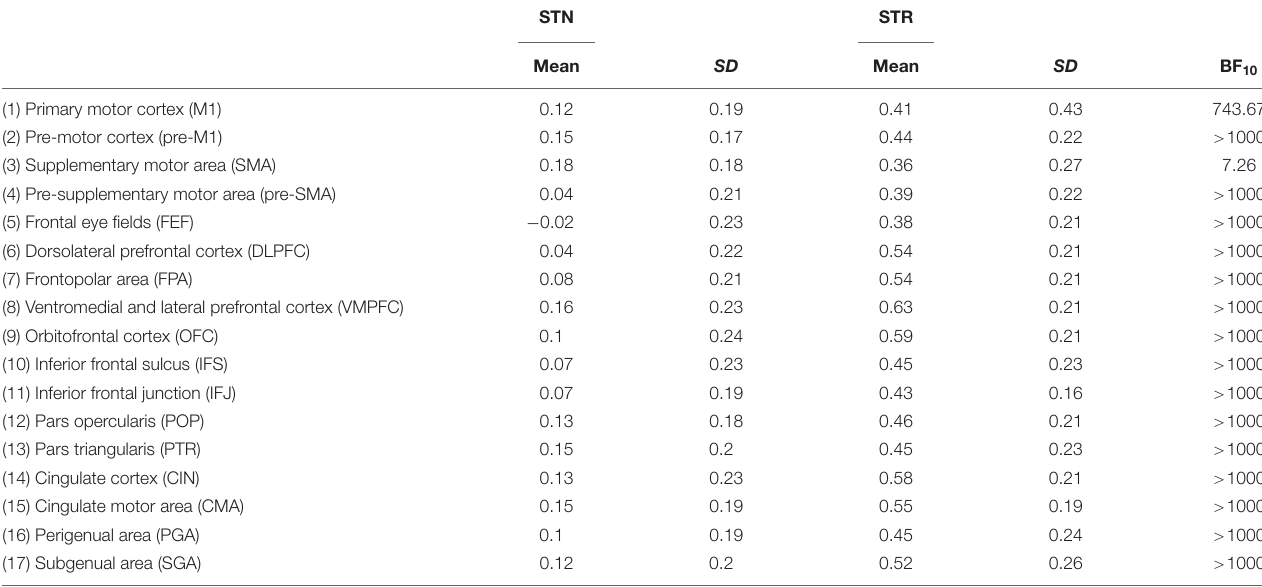
TABLE 7 | Summary statistics of rs-fMRI correlation coefficient for the STN and STR to cortex averaged over hemispheres. STN STR